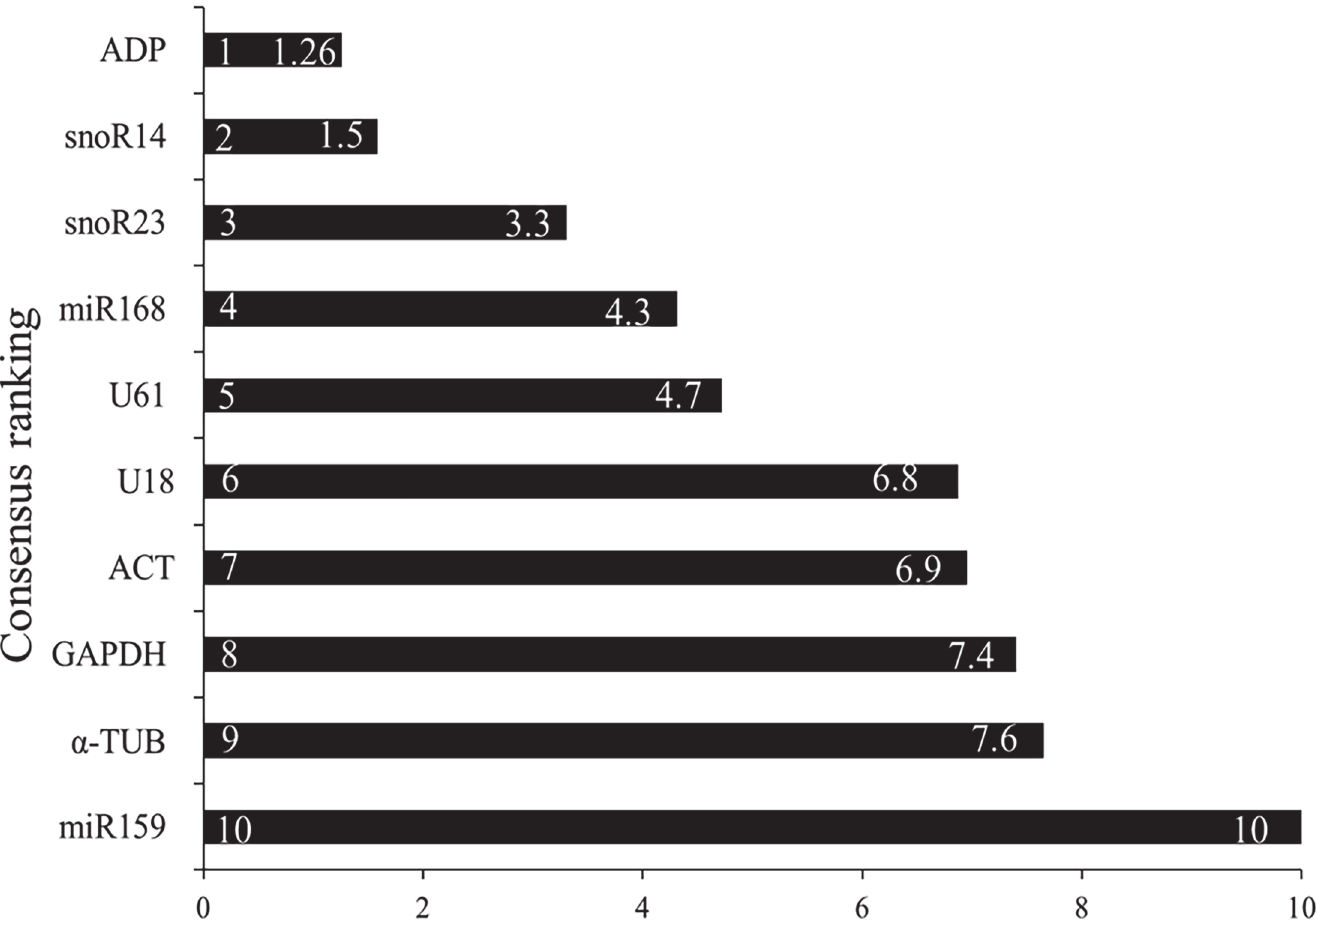
Fig 3. Consensus ranking of ten reference genes. Each candidate gene was assessed in the composite of all samples (n = 44). For each candidate, the consensus ranking was calculated as geometric mean of all rankings suggested by three algorithms; geNorm, Norm Finder and Bestkeeper.